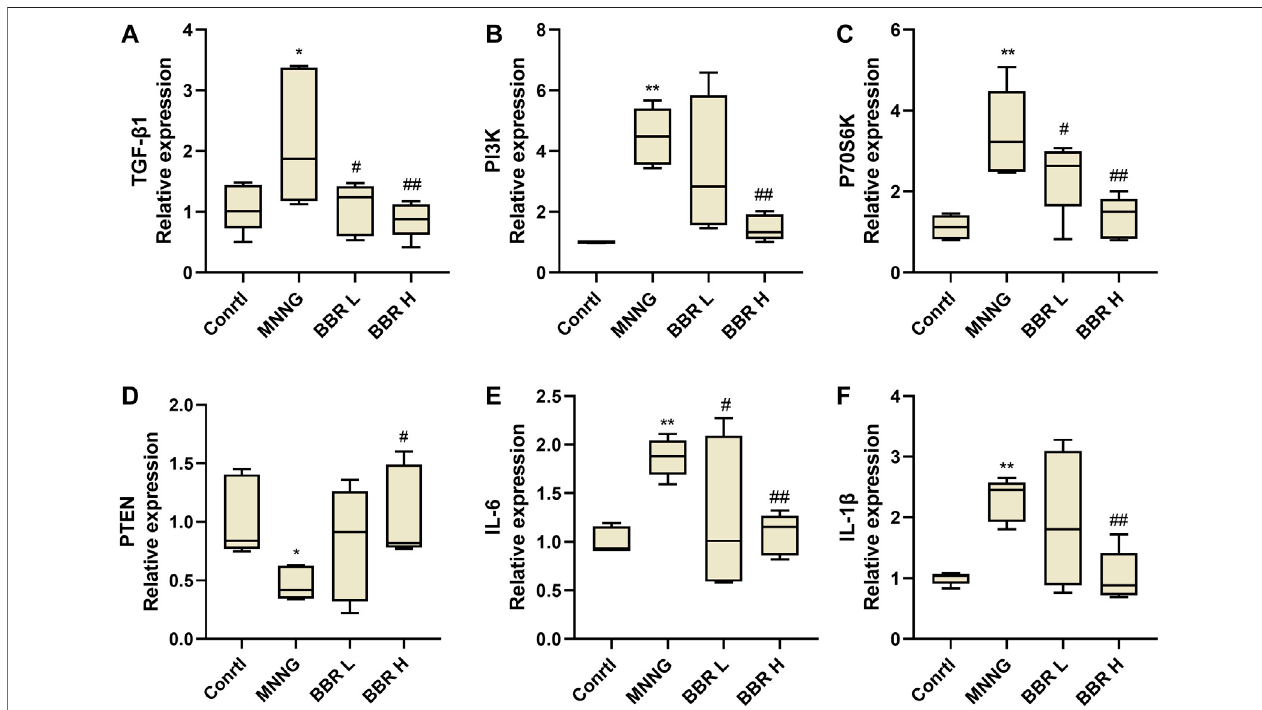
FIGURE 7 | Histogram of TGF- β 1 (A) , PI3K (B) , P70S6K (C) , PTEN (D) , IL-6 (E) and IL-1 β (F) mRNA expression in gastric tissue of CAG rats by RT-PCR. Data were shown as mean ± SD ( N (cid:1) 5). ** < 0.01 vs. control group. ## < 0.01 vs. MNNG group; # < 0.05 vs. MNNG group. Ctrl, Control; BBR L, BBR low dose group; BBR H, BBR high dose